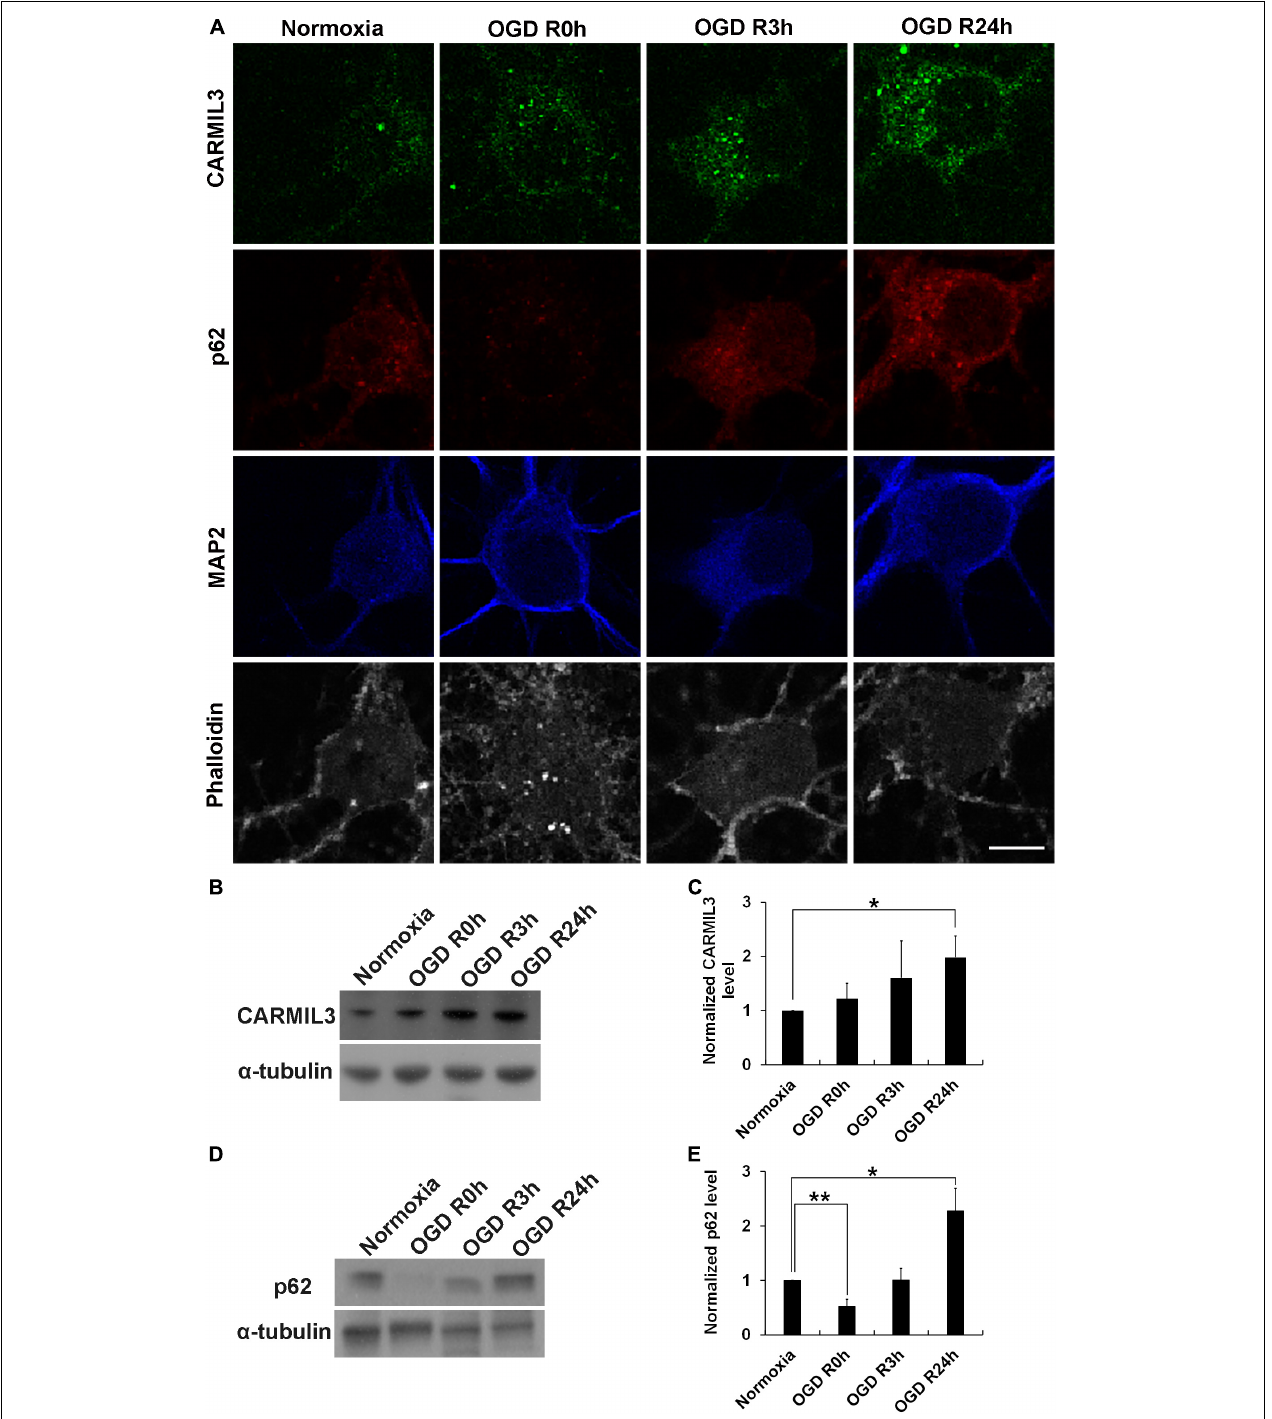
FIGURE 11 | CARMIL3 expression in rat primary cortical neuronal culture. (A) Immunofluorescence staining of CARMIL3, p62, MAP2, and phalloidin in primary rat cortical neuron culture after oxygen-glucose deprivation (OGD). CARMIL3 was obviously expressed as a beaded pattern in the neurons at OGD R3h and OGD R24h; p62 had increased expression in neurons at the two points in time. There was more phalloidin staining at OGD R3h, indicating more expression of filamentous actin. (B,C) Western blot for CARMIL3 in neuronal culture showed that OGD R24h had significantly increased CARMIL3 levels than the normoxia group (normalized expression level 1.98 vs. 1, p = 0.025, n = 3; p = 0.065 in comparison among the 4 groups). (D,E) Western blot for p62 in neuronal culture revealed lower expression in the OGD R0h group while higher expression in the OGD R24h group compared with that in the normoxia group. * p < 0.05; ** p < 0.01. Scale bar = 10 µ